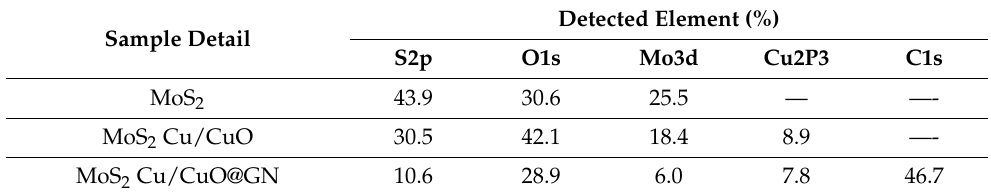
Table 2. XPS Elemental composition of MoS 2 , MoS 2 -Cu/CuO and MoS 2 -Cu/CuO@GN.